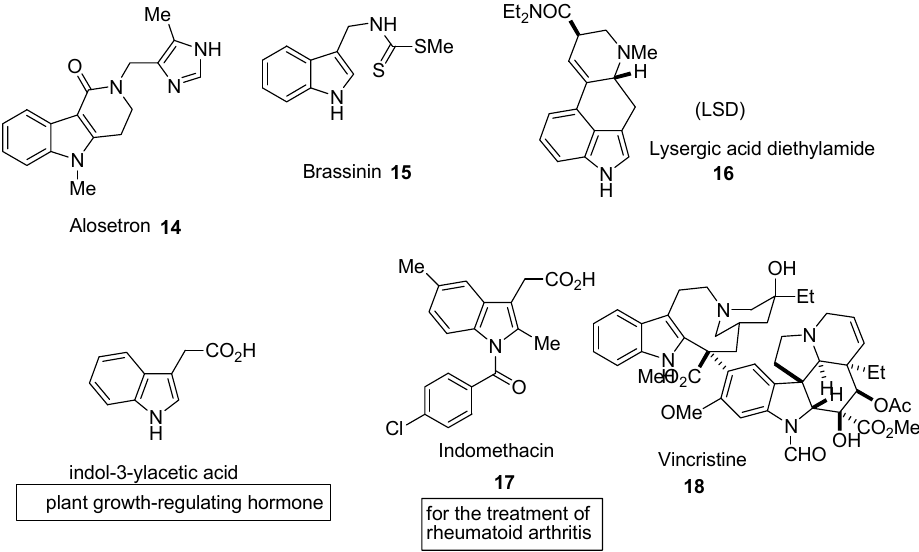
Figure 5. Indoles with important activity in plants and